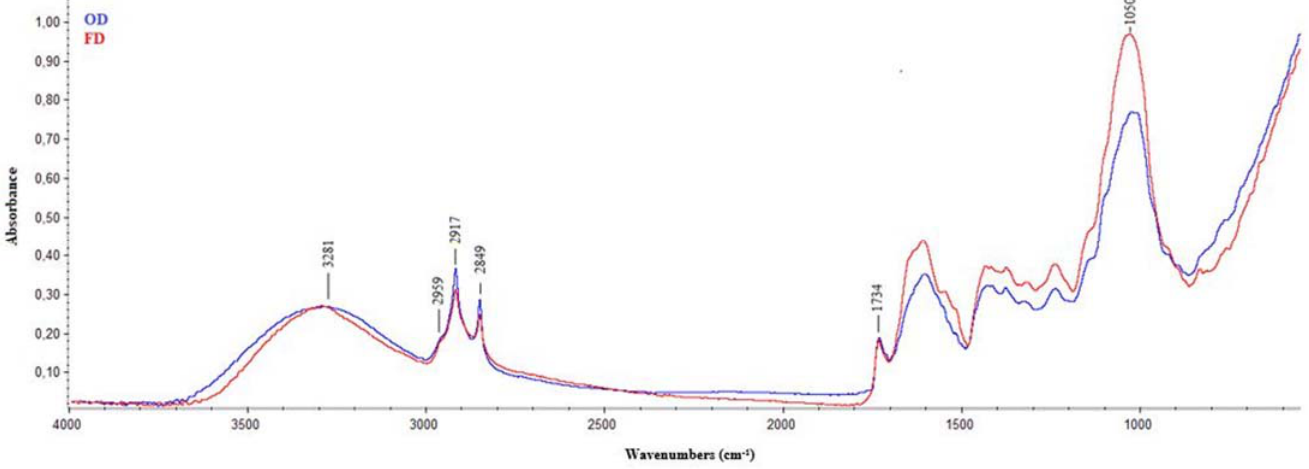
Figure 1. Average IR spectra of samples analyzed. Red line indicates freeze-dried (FD) samples, and blue line indicates oven-dried (OD) ones.